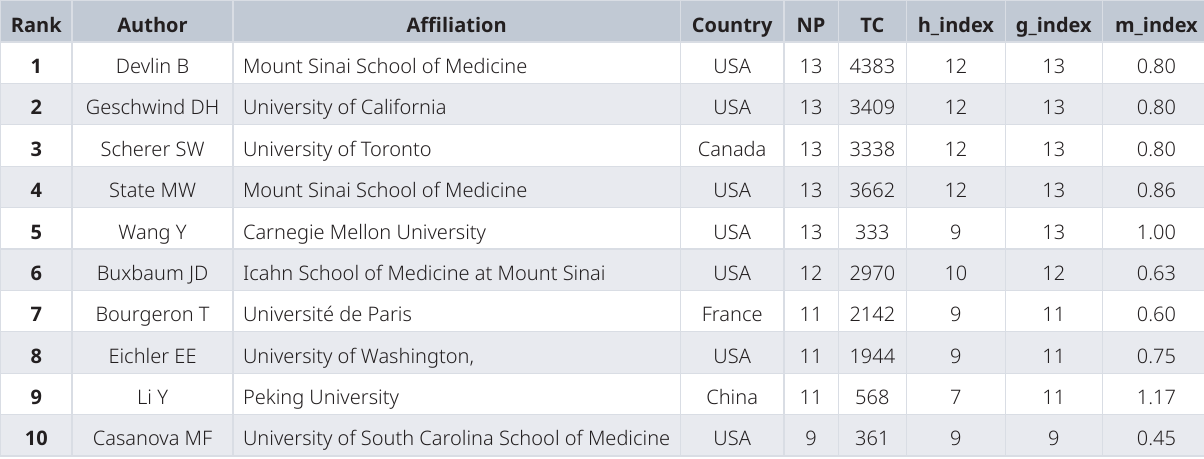
Table 6. Top ten most productive authors in autism